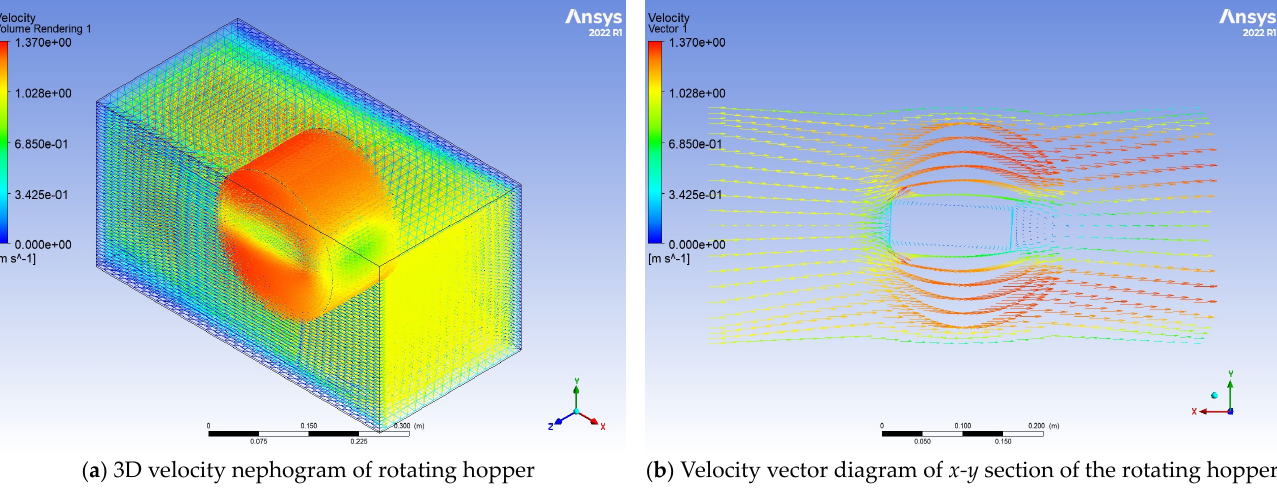
Figure 21. Three-dimensional velocity nephogram of r = 4, v = 1 freezer and x-y plane velocity vector diagram of